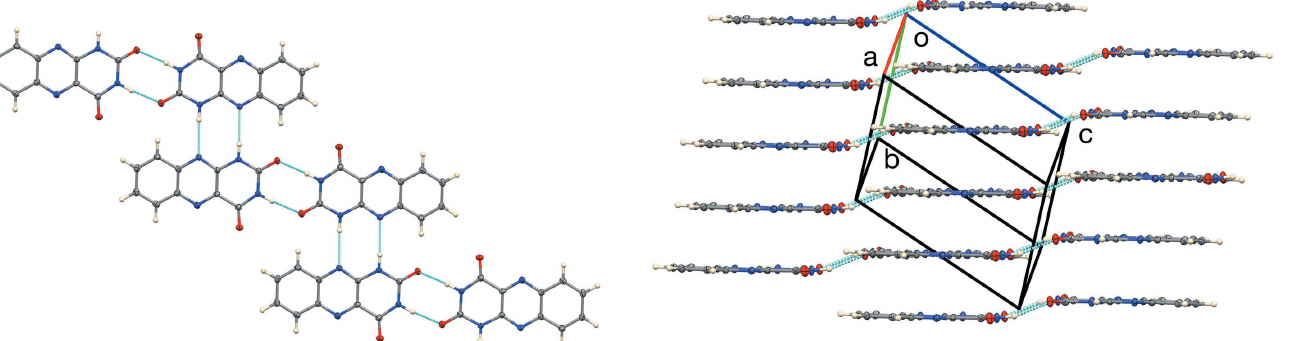
Figure 3 The unit cell, showing the offsets of hydrogen-bonded dimers.